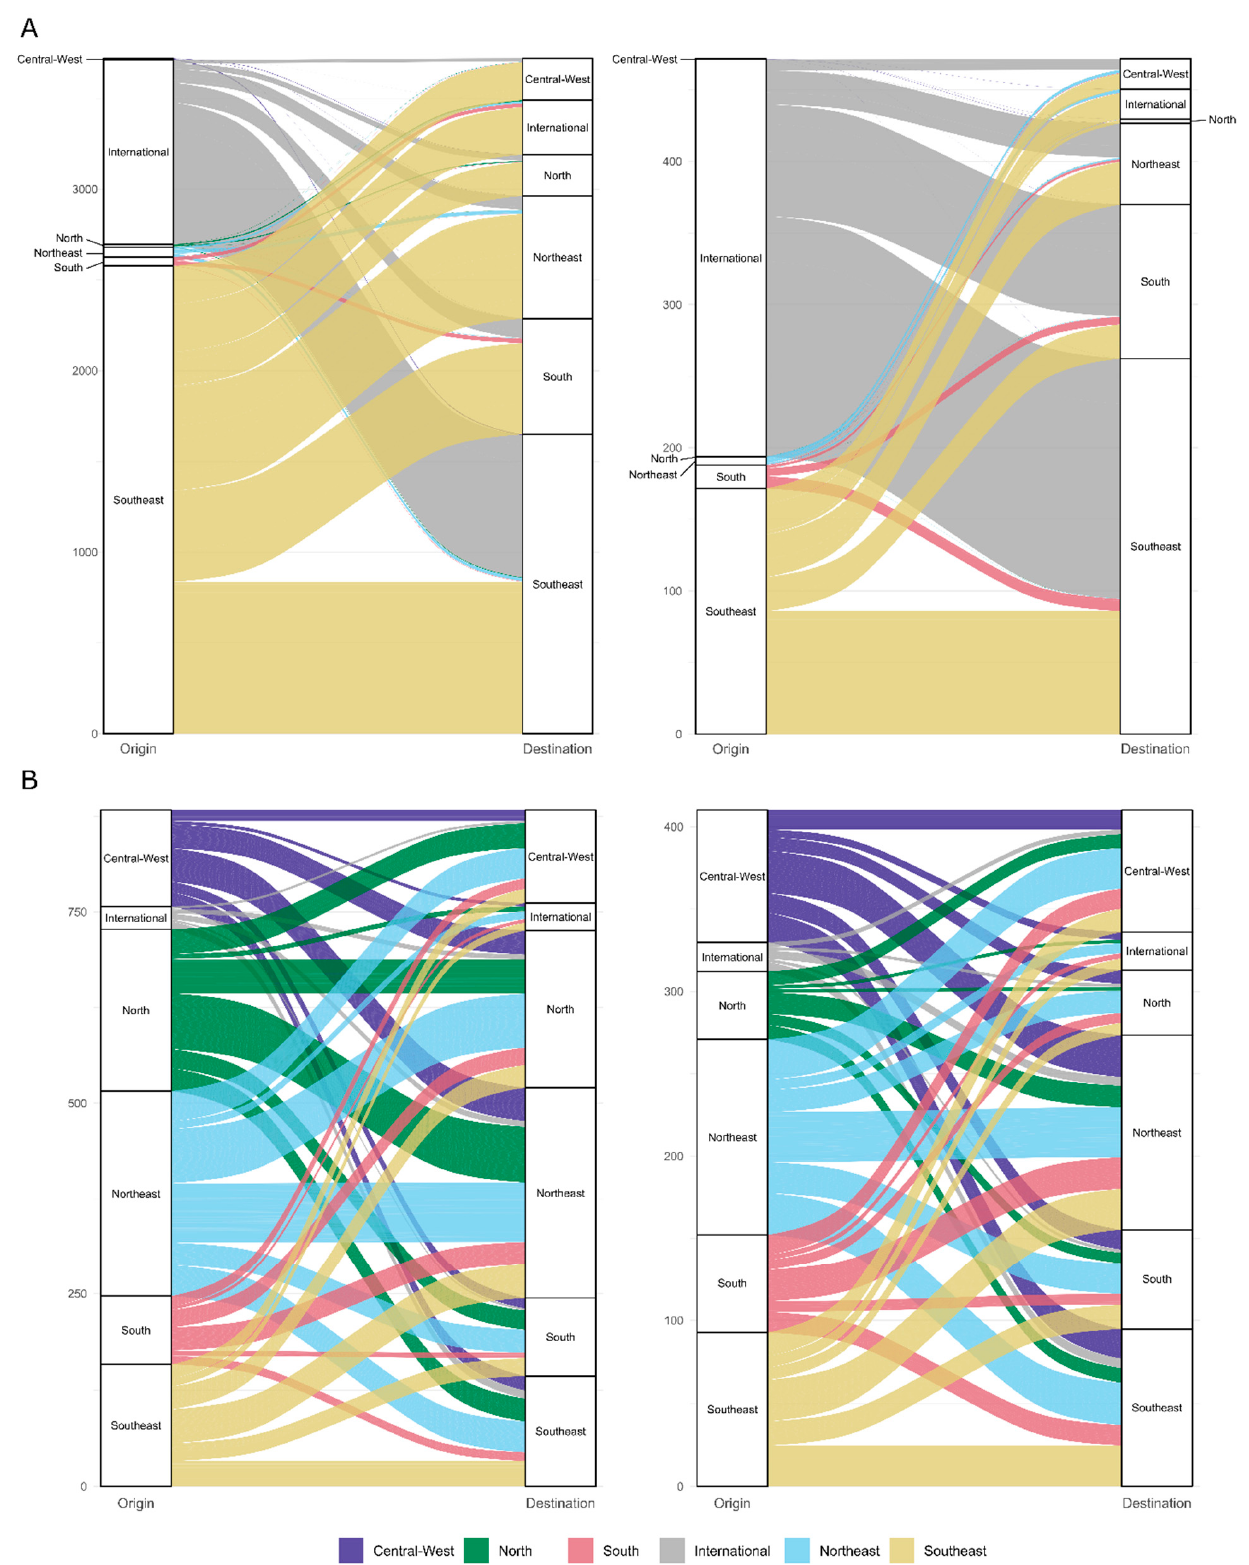
Figure 3. The number of introduction events ( A ) and dispersal rates ( B ) of the Omicron lineages BA.1 ( left ) and BA.2 ( right ) between Brazilian regions, estimated from the proportional dataset. Colors represent the region of the event’s origin.